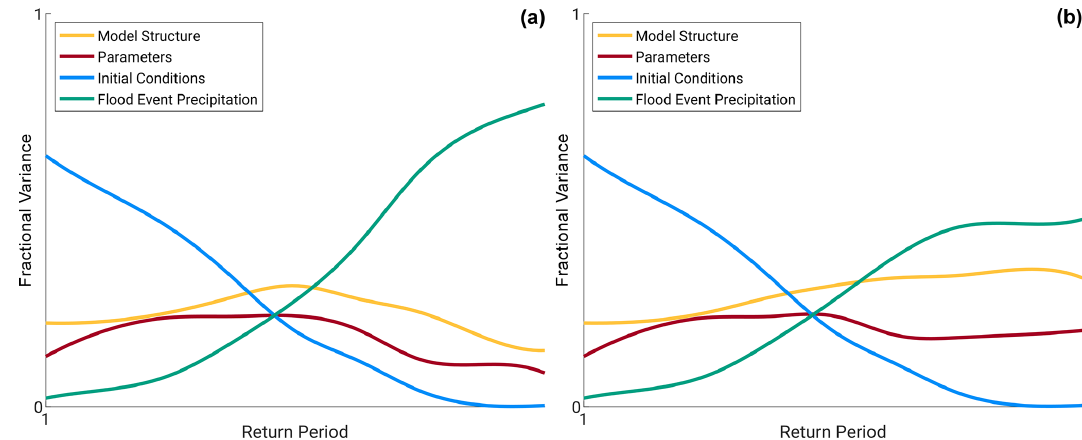
Figure 1. Conceptual contribution of relative variance contribution from initial conditions (blue), model parameters (red), model structure (orange), and precipitation event forcing (green) across return periods (larger return periods towards the right) for (a) the base case and (b) one possible alternative, where model structure has similar importance to precipitation event forcing for extreme events.